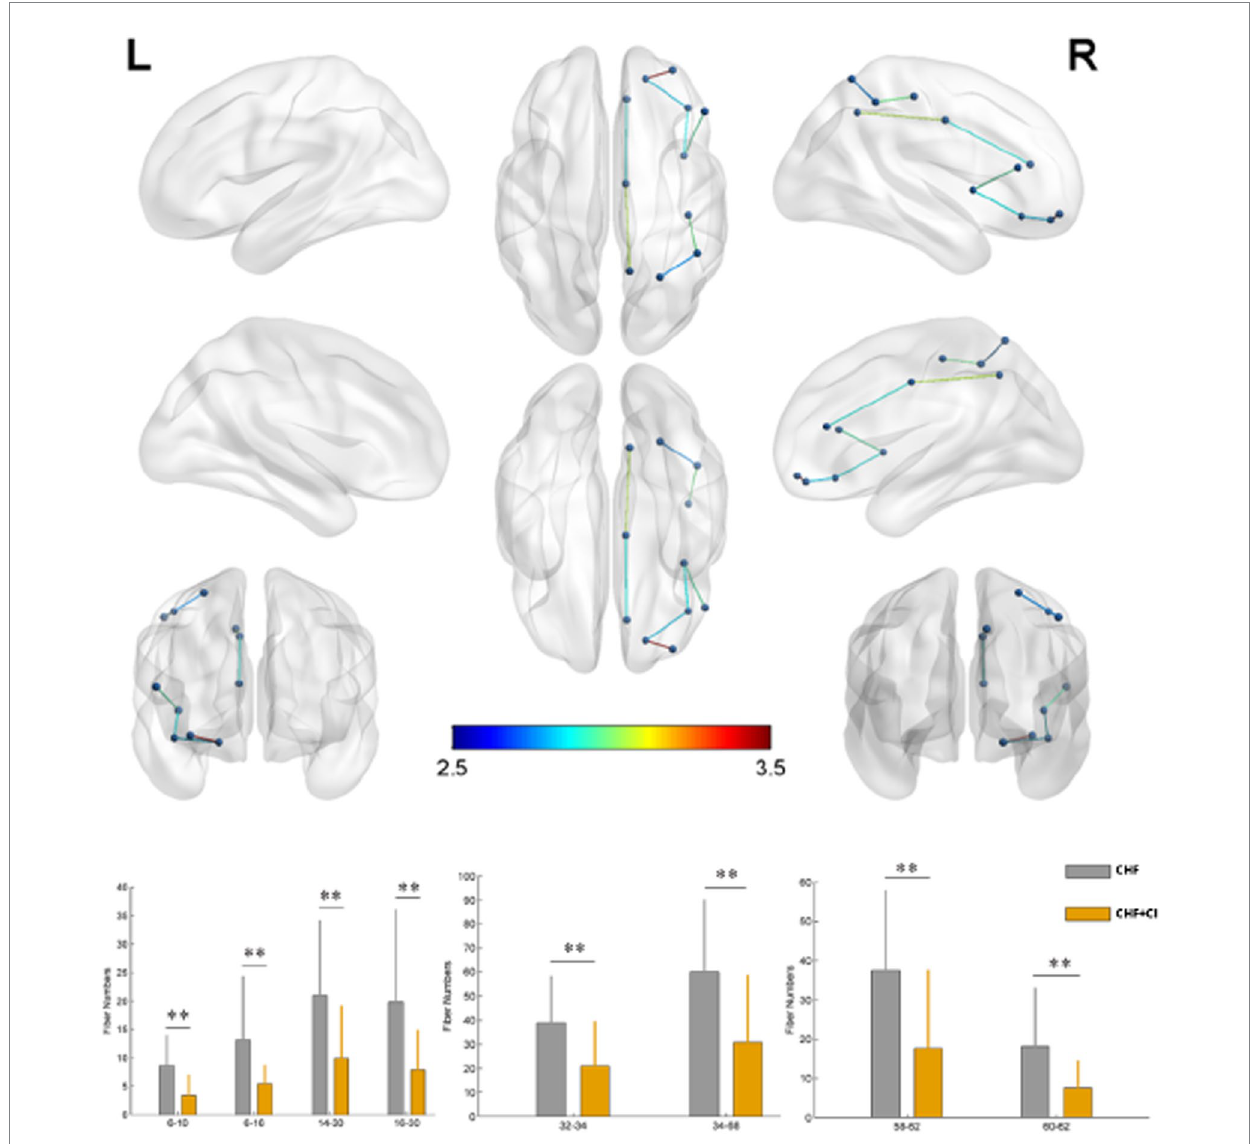
FIGURE 3 Connection comparisons between the CHF group and the CHF + CI group. Regions exhibited significantly decreased connectivity in the CHF + CI compared to the CHF (NBS corrected ** p <